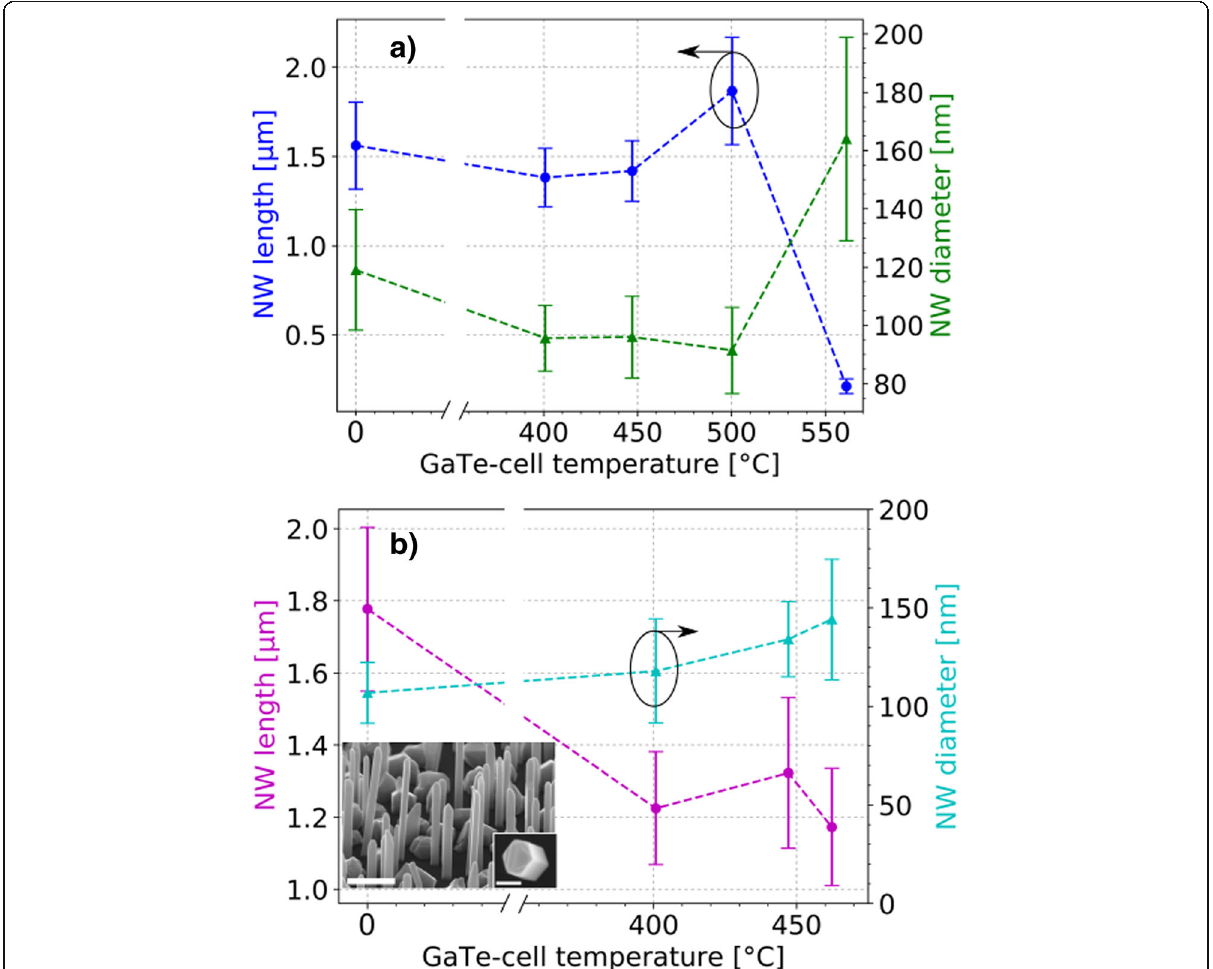
Fig. 1 Nanowire morphology. Nanowire mean length and diameter at different GaTe-cell temperatures. a Series A was grown at an As-partial- pressure of about 3.3 × 10 – 5 Torr. b Series B was grown at an As-partial pressure of 2.3 × 10 – 5 Torr. The broken lines are guidance for the eyes. The SEM micrograph shown in the inset depicts undoped InAs NWs surrounded by crystallites formed during growth. The scale bar is 300 nm and 120 nm,